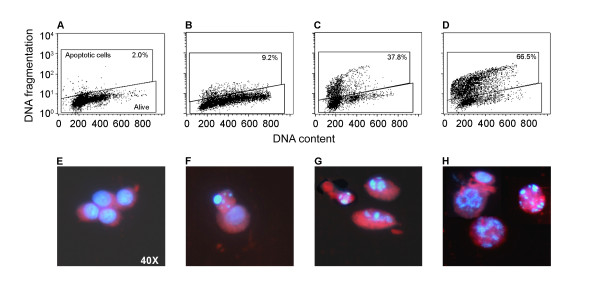
Representative cytofluorimetric dot plots of one of the TUNEL experiments and characteristic morphologic images of apoptotic cells observed after drug exposure. A and E, untreated cells; B and F, after a 1-h exposure to Doc 0.01 μM followed by a 120-h w.o.; C and G, after a 120-h continuous exposure to Zol 100 μM; D and H, after exposure to the combination Doc + Zol → Zol.